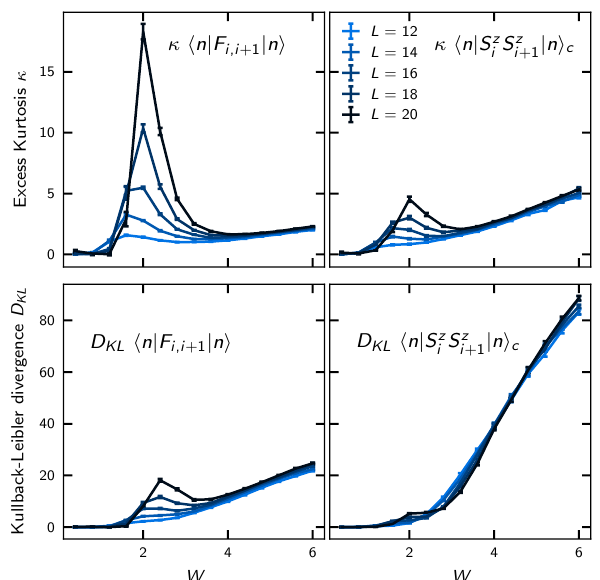
/σ 4 ) − 3 of the distribution of diago- 4 | n 〉 and (right) connected correlation 〈 S z i , i + 1